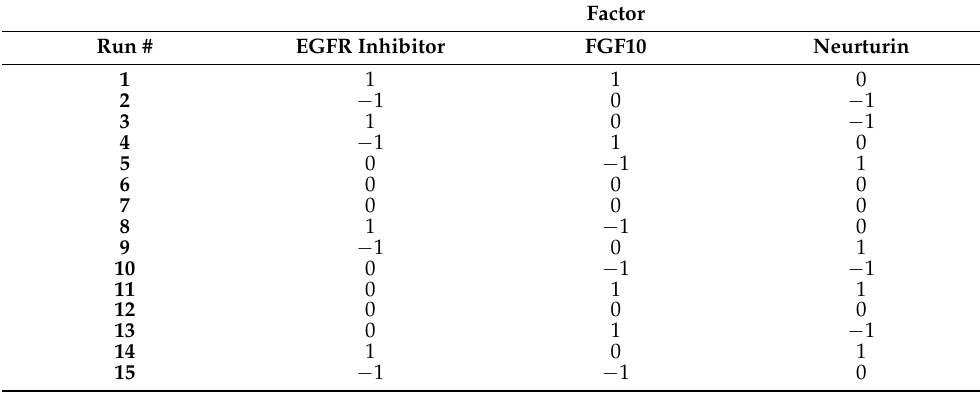
Table 3. Experimental Design for the Box–Behnken DoE Created using JMP. Each Row (Run) Indi- cates an Independent Experiment with the Factors Present At the − 1, 0, or +1 Level as Indicated. Concentrations for These Levels are Shown in Table